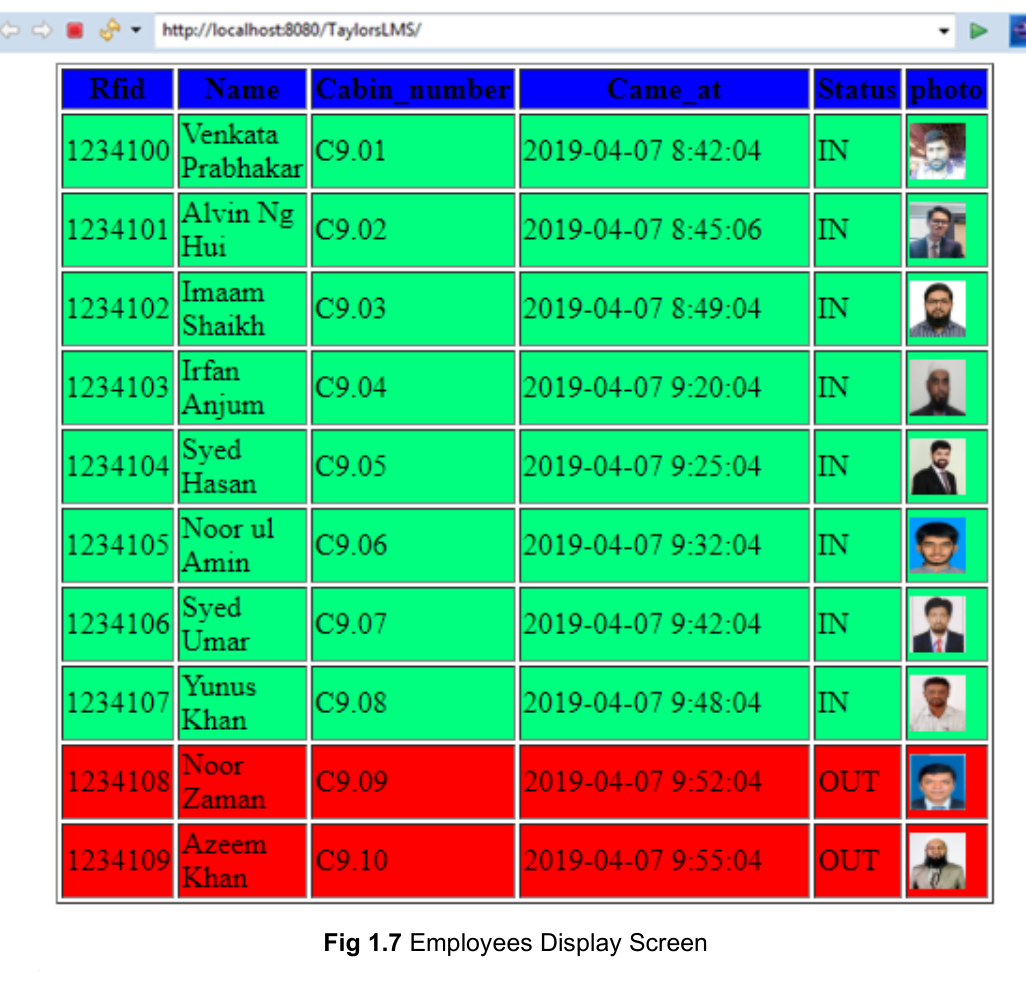
Fig 1.7 Employees Display Screen